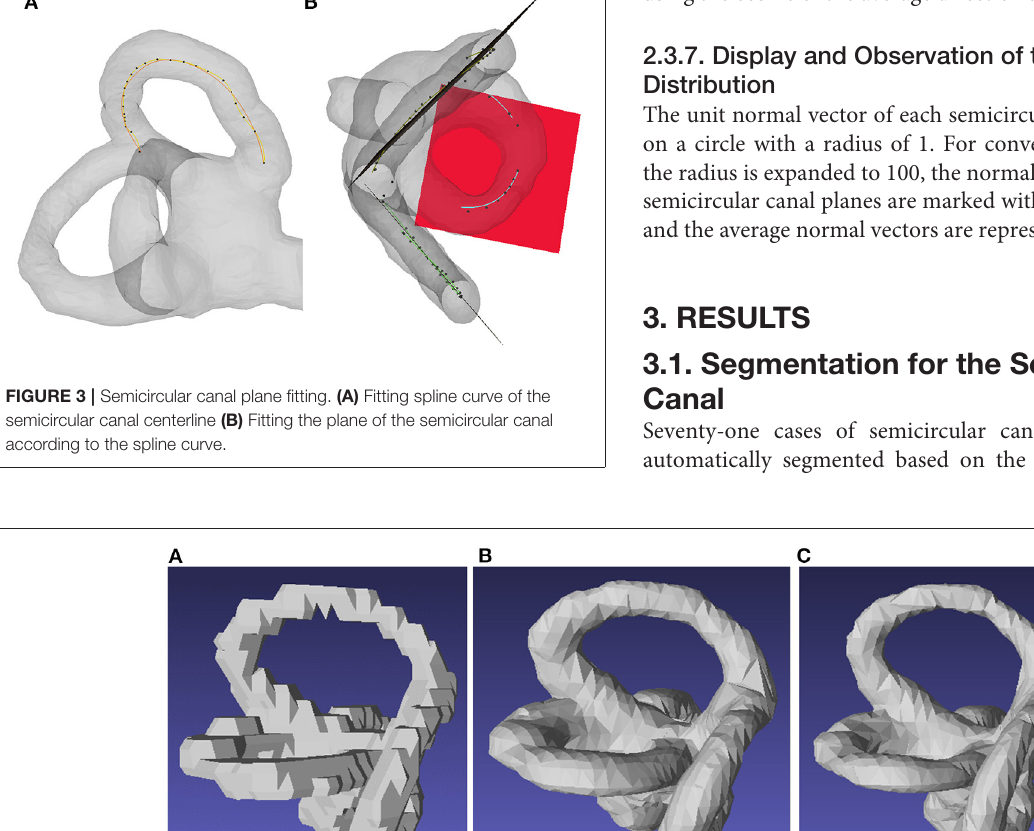
Frontiers in Neurology |